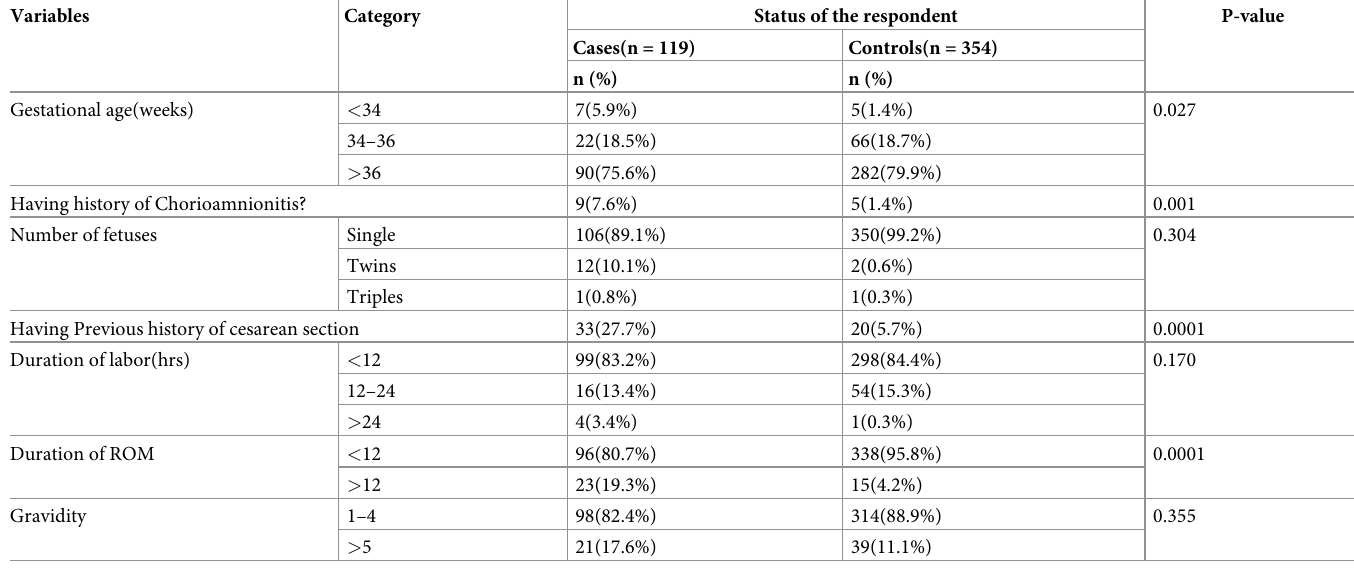
Table 2. Obstetric and related characteristics of the mothers with post-operative surgical site infection at public hospitals of Dire Dawa administration, 2019.